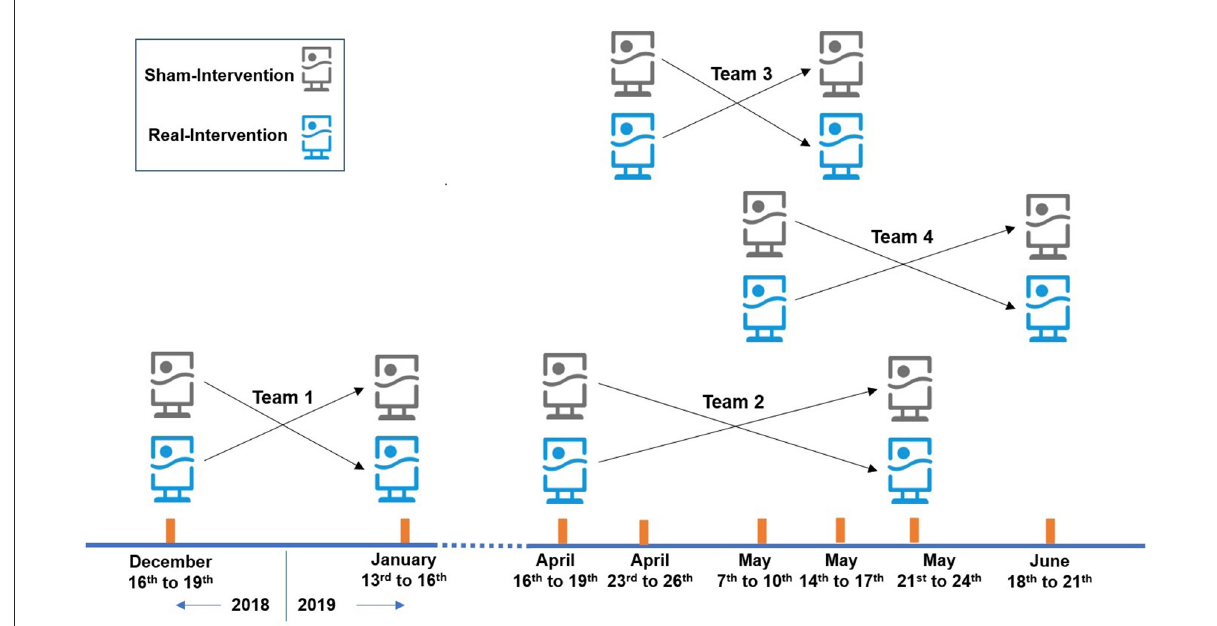
FIGURE1 Arrangement of the